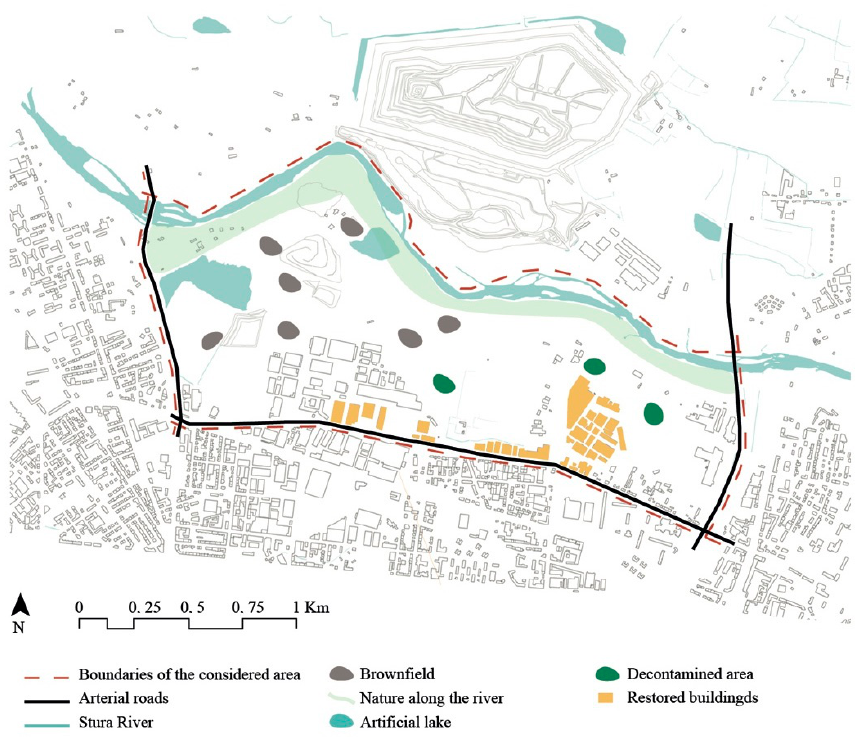
Figure 7. Strategic scenario intervention scheme.